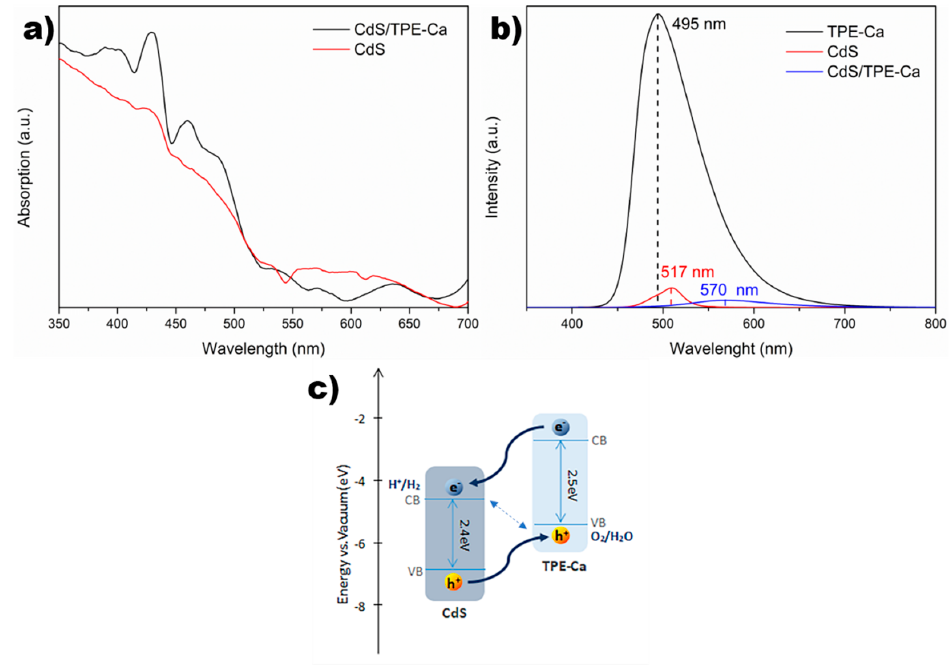
Figure 2. ( a ) DRUVS spectra of CdS and CdS/TPE-Ca photocatalysts, the absorption